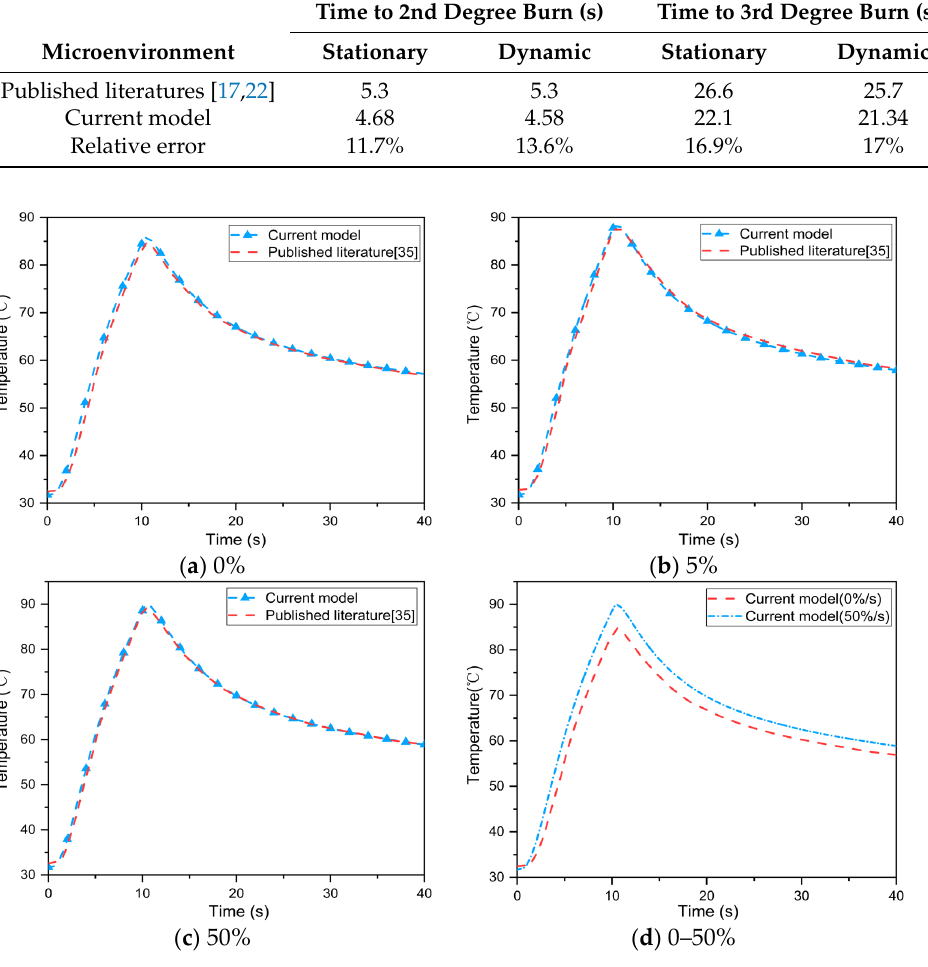
Figure 7. Comparison between the temperature at epidermis–dermis interface under different thermal shrinkage rates predicted by the current model and the published literature [35].